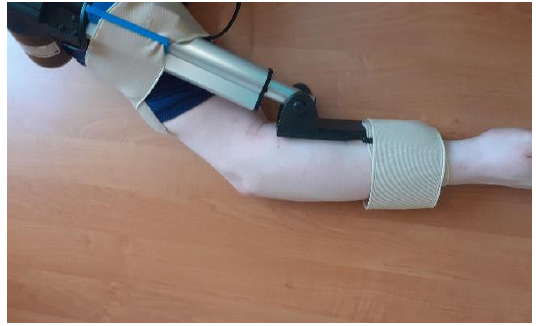
Figure 14. Exoskeleton on the user.